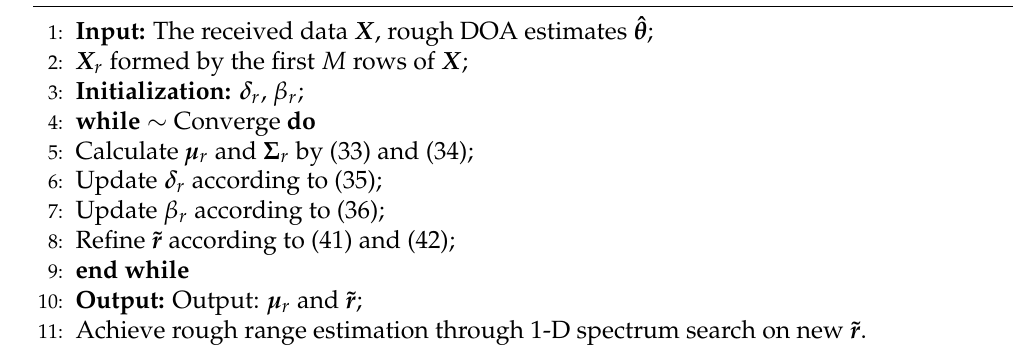
Algorithm 2 Rough Range